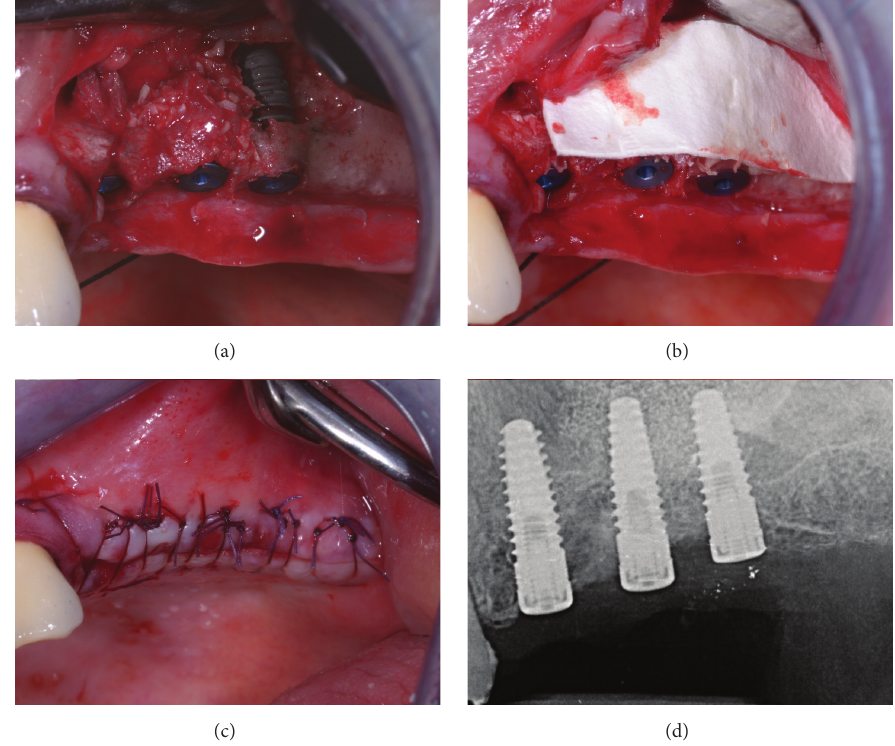
Figure 10: After partially filling the grafting site, implants are being placed with the aid of the surgical guide (a) and filling is complete (b). Implants are left submerged (c), and an intraoral control radiograph is collected (d).